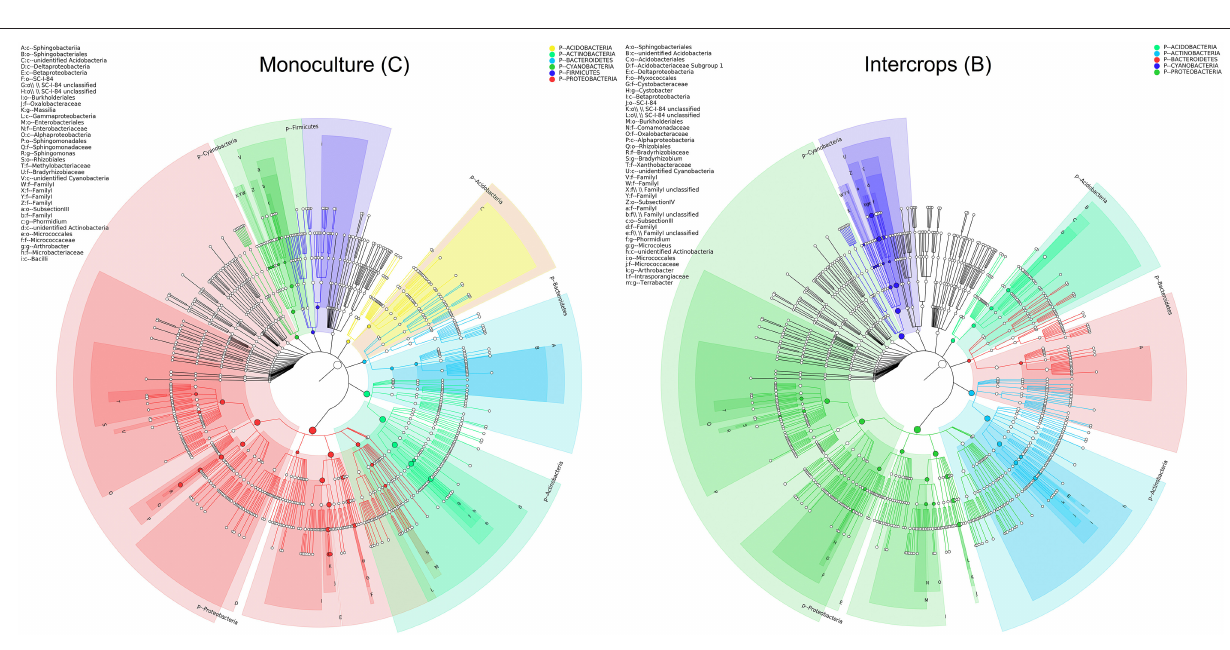
OTU species annotation results for a group of all samples were presented in conjunction with the GRAPhlAn. An OTU tree of 16S rRNA and ITS monoculture and intercrop are shown